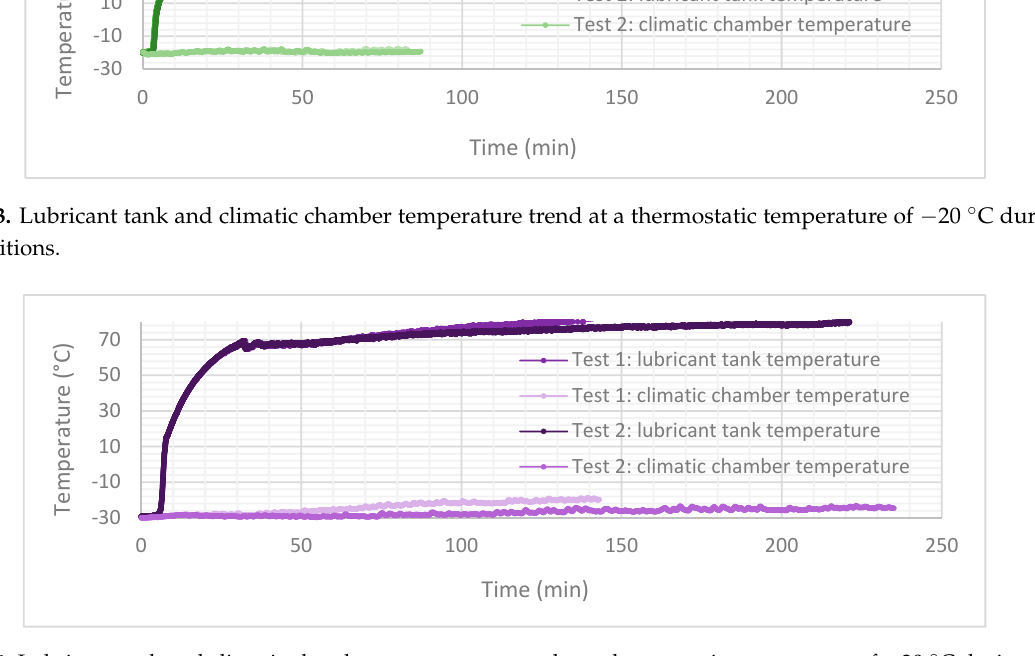
Figure A5. Normalized air volume flow rate trend at a thermostatic temperature of 0 °C during the two repetitions.